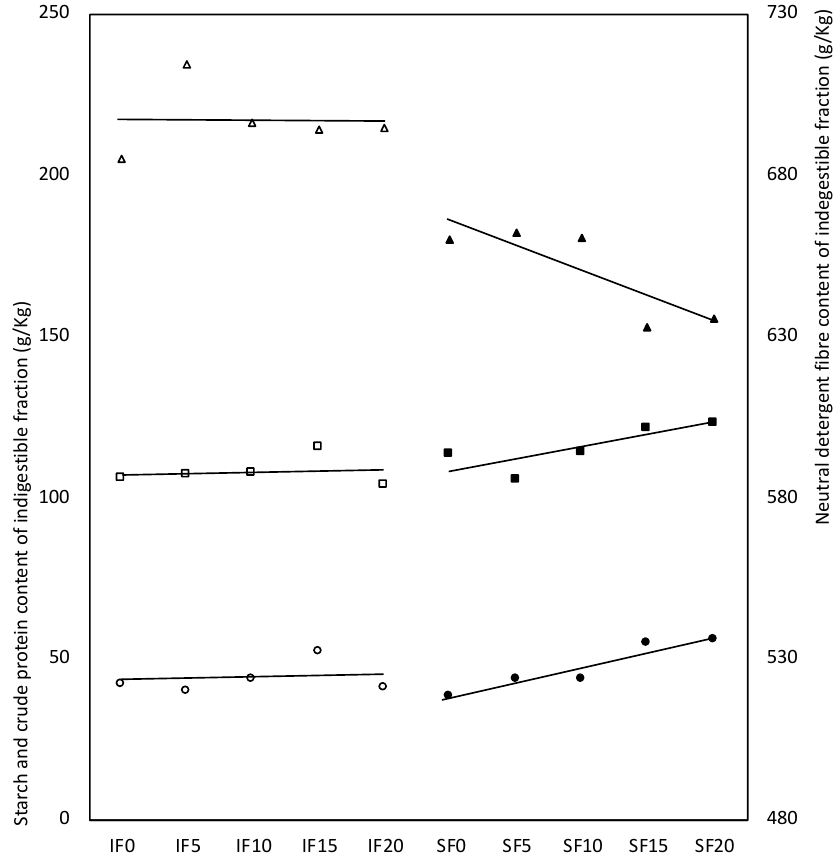
Figure 2. E ff ect of fenugreek seed gum (FSG) level of inclusion in the experimental diets (SF and IF) on the starch, (cid:3) crude protein and (cid:52) neutral detergent fibre content of indigestible fraction after in vitro incubation with pepsin and pancreatin (symbols without filling in IF diets and with filling in SF diets). SF0, SF5, SF10, SF15 and SF20, SF diet with 0, 5, 10, 15 and 20 g of FSG included per kg of feed; IF0, IF5, IF10, IF15 and IF20, IF diet with 0, 5, 10, 15 and 20 g of FSG included per kg of feed.